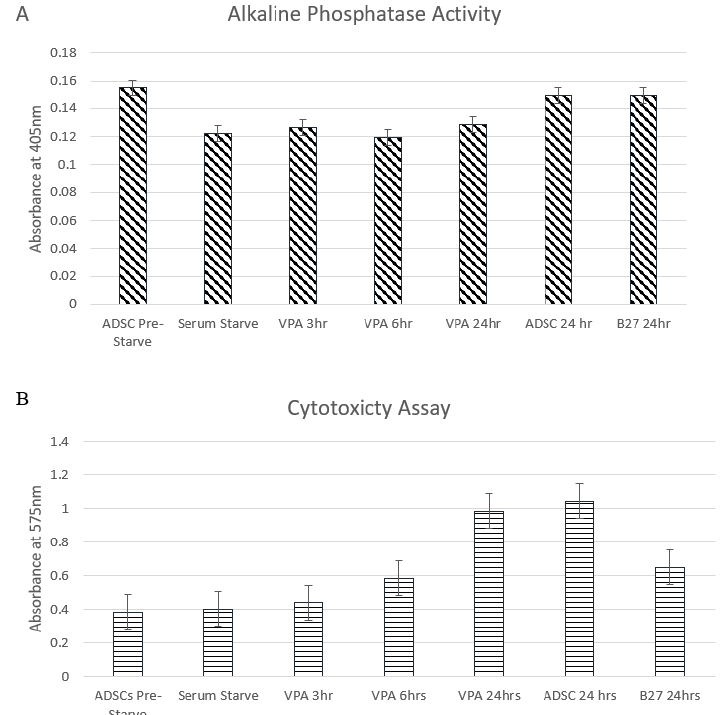
Figure 1. Live cell images of the temporal differentiation of human adipose derived stem cells (ADSCs) induced with 0.2 mM valproic acid (VPA) at ( A ) 0 h, ( B ) 3 h, ( C ) 6 h, and ( D ) 24 h at 10 × magnification. The cellular morphology changes rapidly through the time points, with cells adopting a more slender and bipolar orientation with neurite extensions (arrows). ( E ) Average cell count across the treatments including all controls with standard error bars. Relatively minimal changes in numbers are shown across all treatments. A Student’s t-test revealed no significant change in cell numbers. Cells 2020 , 8 , x FOR PEER